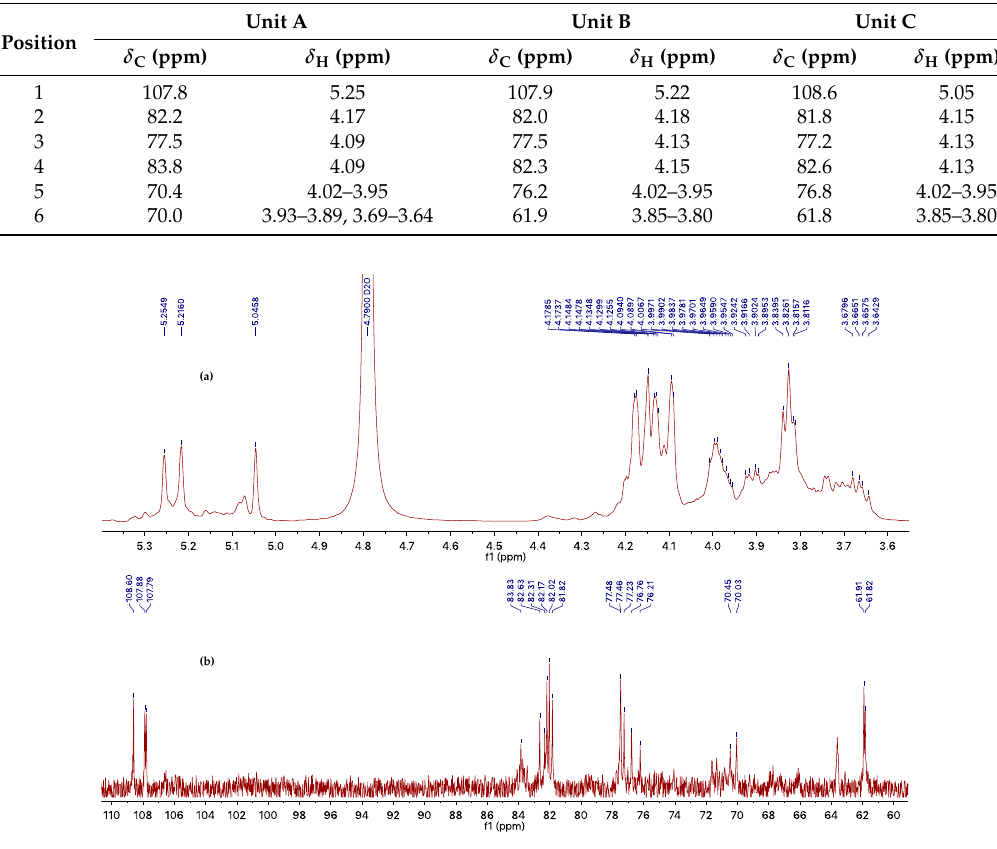
Figure 3. 1 H- ( a ) and 13 C- ( b ) NMR spectra of impure galactan in D 2 O.